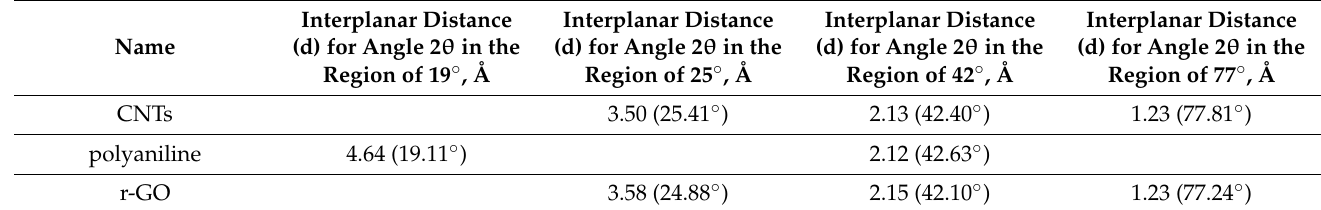
Table 1. Interplanar distances of initial materials.